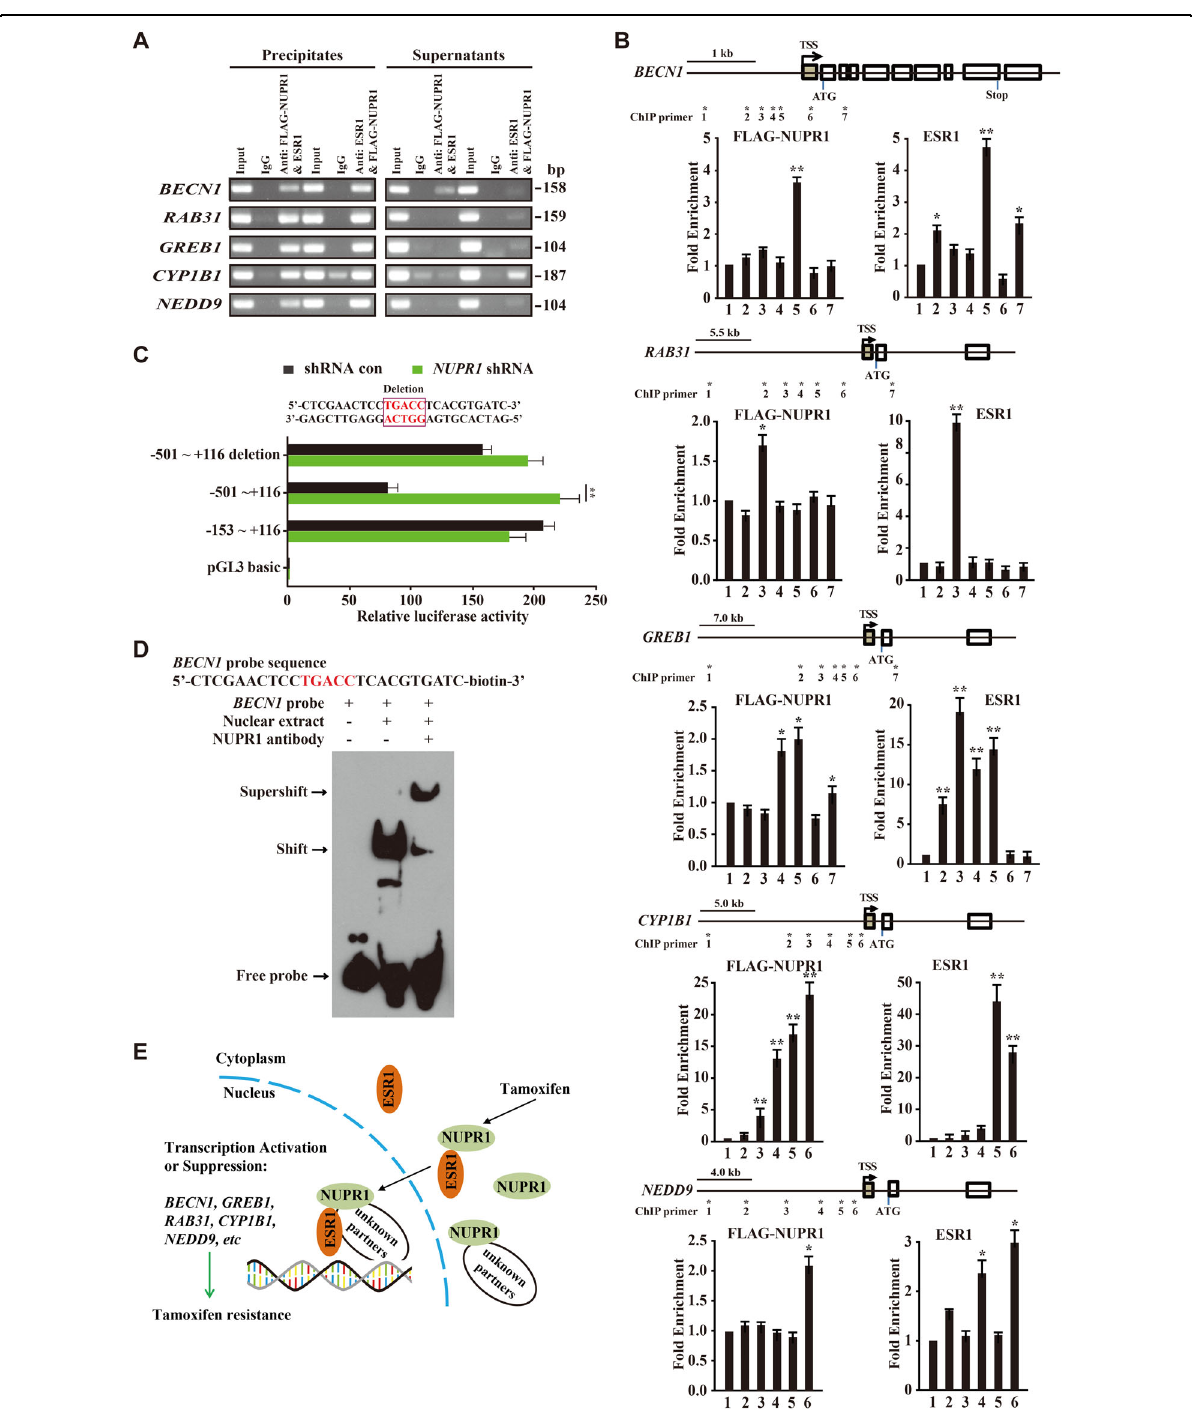
Fig. 5 NUPR1 directly suppresses BECN1 transcription in MCF-7TamR cells. A ChIP-re-ChIP showing the enhanced occupancy of FLAG-NUPR1 and ESR1 on the promoters of the indicated genes. Sequential antibodies used for the fi rst ChIP and second ChIP are indicated above the lanes. B Quantitative RT-PCR was performed to con fi rm transcriptional changes of the indicated genes identi fi ed from the ChIP-seq data. RNA levels are presented as the relative fold change compared to the levels in the control shRNA samples. The mean ± SD of three replicates is shown ( n = 3). C Diagram shows the deletion of the luciferase reporter upstream of the BECN1 TSS (upper panel); luciferase reporter studies with a mutation of the ESR1 binding site within the − 501 to + 116 segment, which partially abrogated basal promoter enhancement (lower panel). The mean ± SD of three independent luciferase reporter activities is shown. d EMSA shows the mobility shift of the probe with BECN1 sequence containing an ESR1 binding site, with a supershift following anti- NUPR1 antibody treatment. E Proposed working model for the role of NUPR1:ESR1 in the transcriptional regulation of their